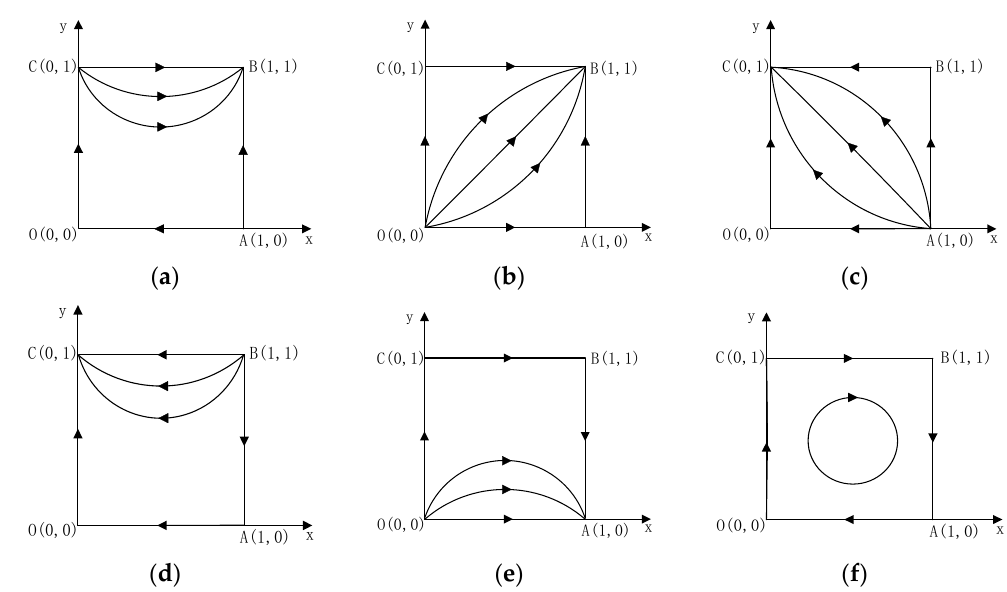
Figure 1. Dynamic evolutionary diagrams: ( a ) Situation 1; ( b ) Situation 2; ( c ) Situation 3; ( d ) Situation 4; ( e ) Situation 5; ( f ) Situation 6.